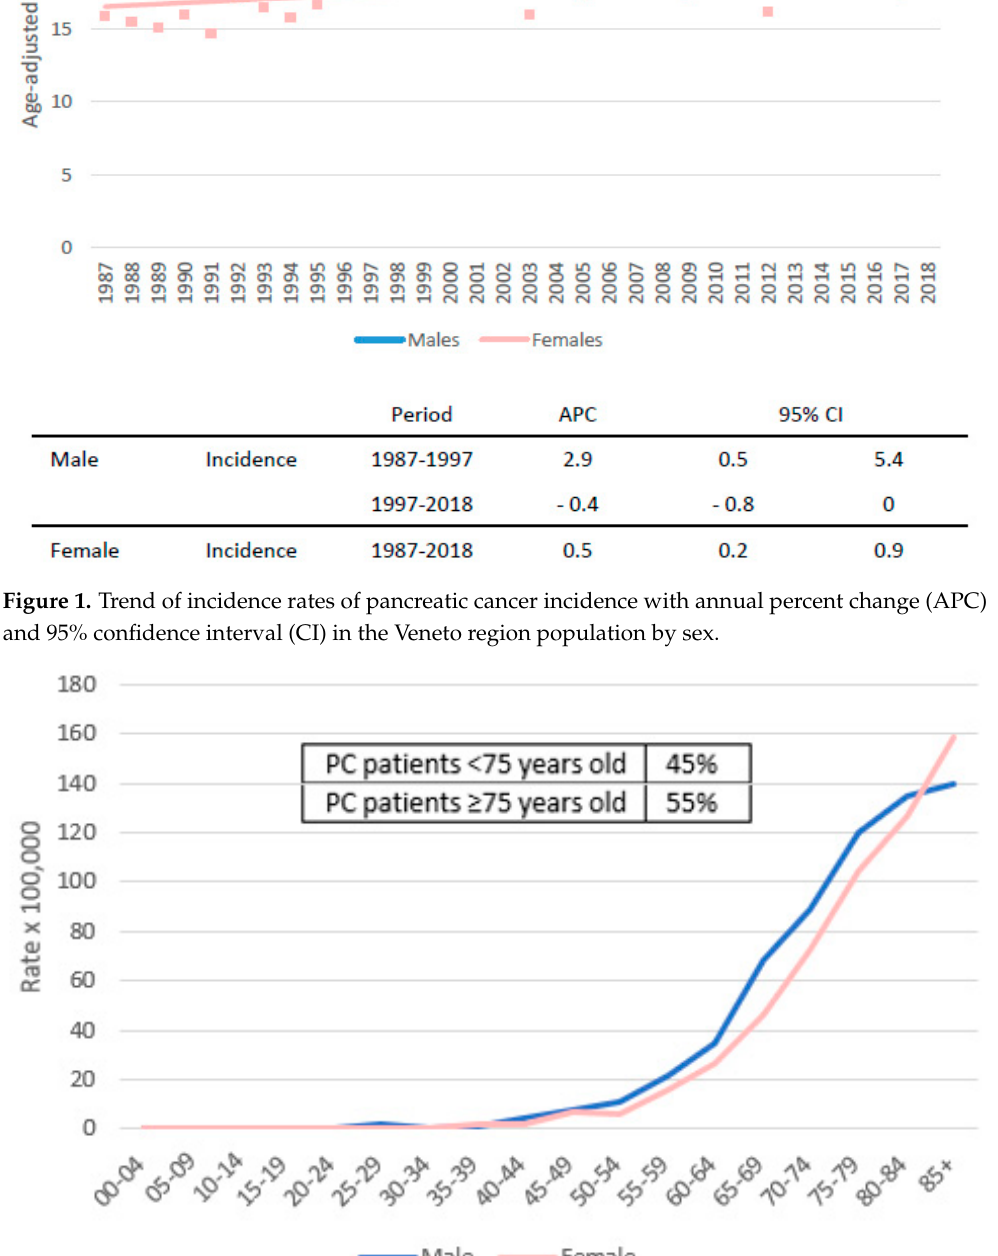
Figure 2. Incidence rate of pancreatic cancer in the Veneto region population by age and sex in 2018.